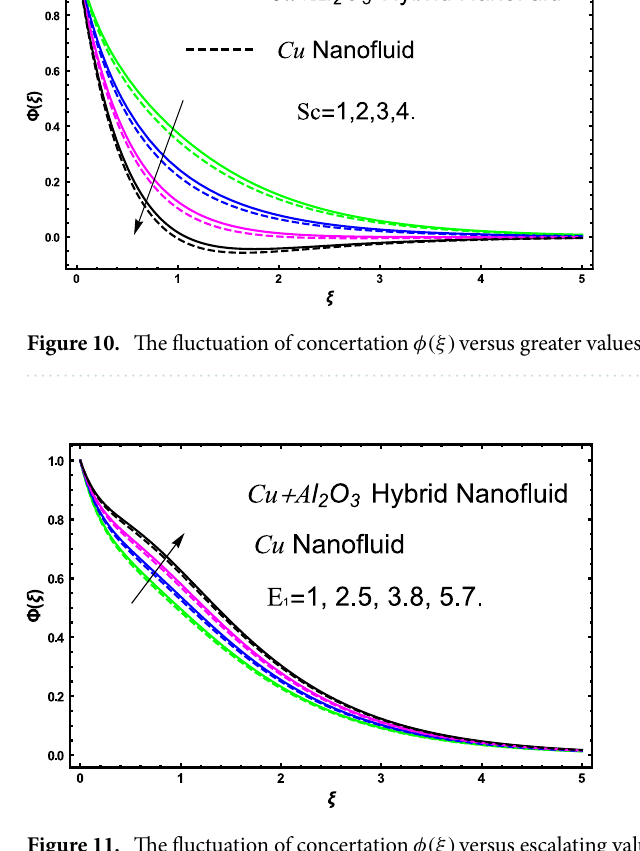
Figure 11. The fluctuation of concertation φ(ξ) versus escalating values of E 1 .